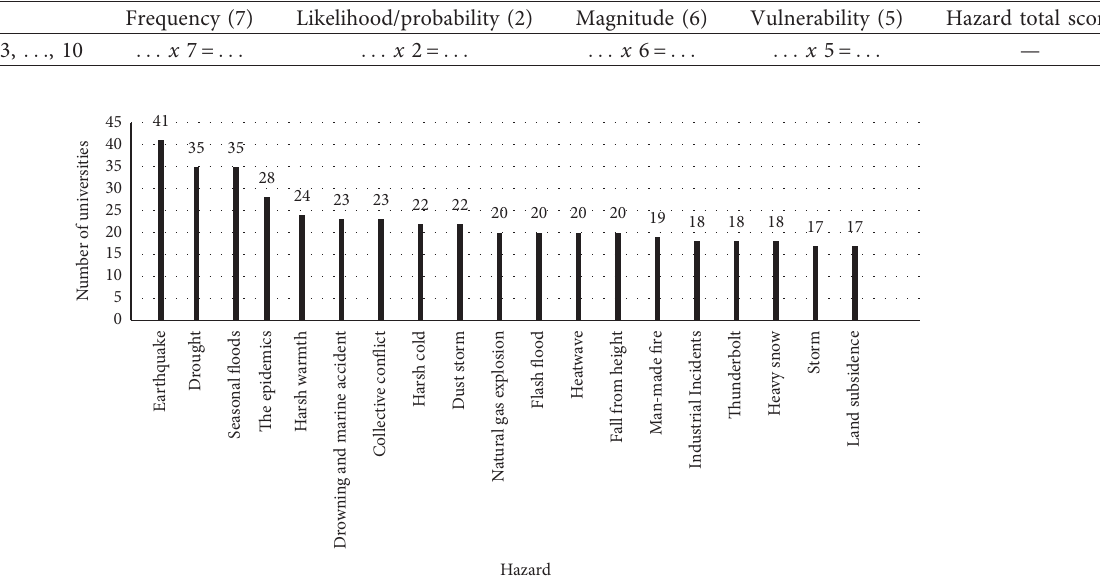
Table 5: Table of identifying the top ten hazards in each medical university.